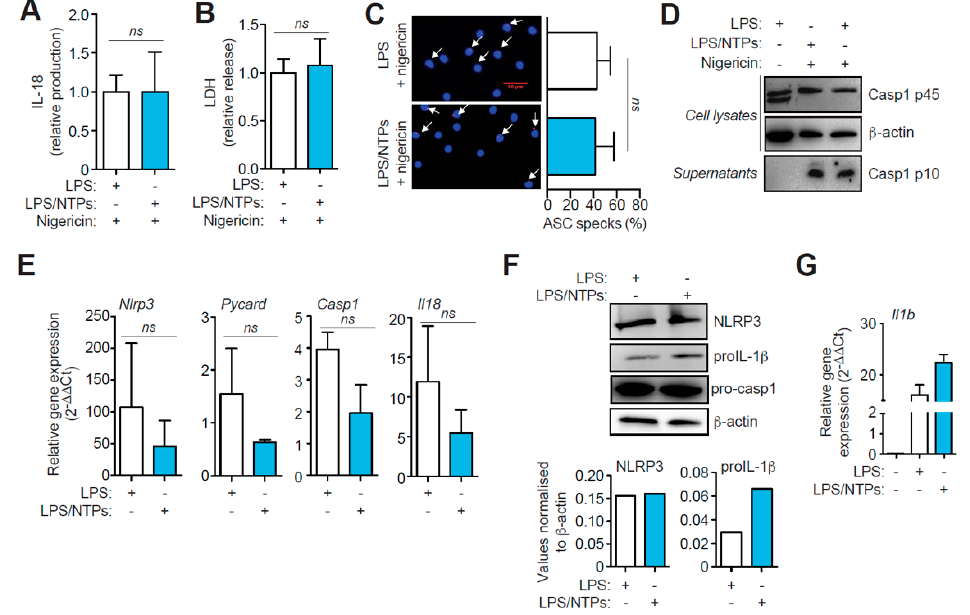
Figure 2. Nucleotides prime Il1b production but do not affect NLRP3 inflammasome activation. ( A ) ELISA of IL-18 produced by peritoneal macrophages (RPMs) primed with LPS in the absence or presence of nucleotides (NTPs: 20 µ M UTP / ATP) and then activated with nigericin. Average of four experiments is shown + SEM, corresponding to an average of 87.8 pg / mL of IL-18 in LPS + nigericin condition. ( B ) LDH release analysis from RPMs treated as in (A). Normalized average + SEM of 16 experiments is shown. ( C ) RPMs treated as in (A) and stained for ASC (red) and nuclei (DAPI, blue) (left panels). White arrows indicate ASC specking macrophages. Red bar indicates scale (30 µ m). Quantification of the percentage of ASC specking macrophages of three fields from duplicates experiments (right panels); graph represents the average of five experiments + SEM. ( D ) Representative analysis by Western blot of cell lysate and supernatants of macrophages primed with LPS only (left and right lanes) or LPS with NTPs (middle lane) and then activated with nigericin as indicated; β -actin loading control is the same shown in Figure 1C, as there are the same blots shown in that figure but revealed with anti-caspase-1 antibody. ( E ) qPCR of the indicated genes after 3 h with LPS (white bars) or LPS + NTPs (blue bars) to Hprt1 housekeeping gene expression and represented as 2 - ∆∆ Ct values; average of 3 experiments is shown + SD. ( F ) Western blot for NLRP3, IL-1 β , pro-caspase-1 and β -actin from cells treated as in ( D ) (top panel); normalized expression of NLRP3 and IL-1 β to β -actin expression (bottom panel). ( G ) qPCR analysis of Il1b gene from cells treated as in ( D ). A representative experiment with duplicates out of 3 experiments performed is shown + SD. ns = not significative.